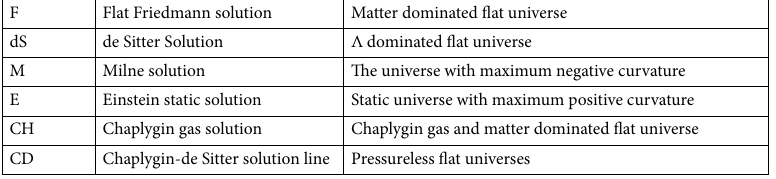
Table 2. Properties of the equilibrium points for k = 0,+1. Here, ξ � √ ( 3 γ =